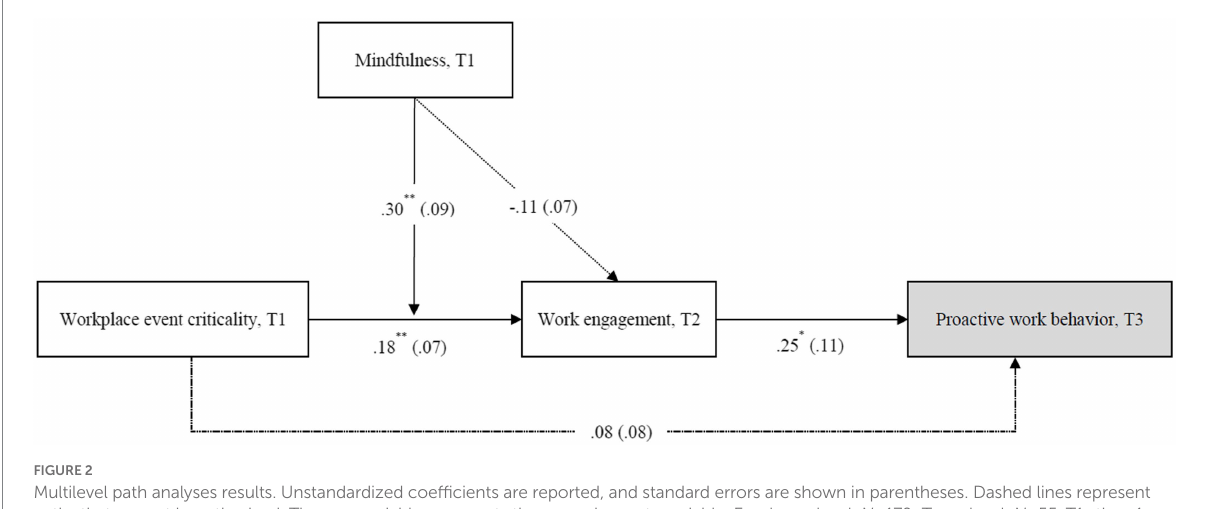
FIGURE 2 Multilevel path analyses results. Unstandardized coefficients are reported, and standard errors are shown in parentheses. Dashed lines represent paths that are not hypothesized. The grey variable represents the supervisor-rate variable. Employee level, N = 179; Team level, N = 55. T1 = time 1, T2 = time 2, and T3 = time 3. For clarity, control variables are not shown in the Figure. * p < 0.05, ** p < 0.01 (two-tailed).